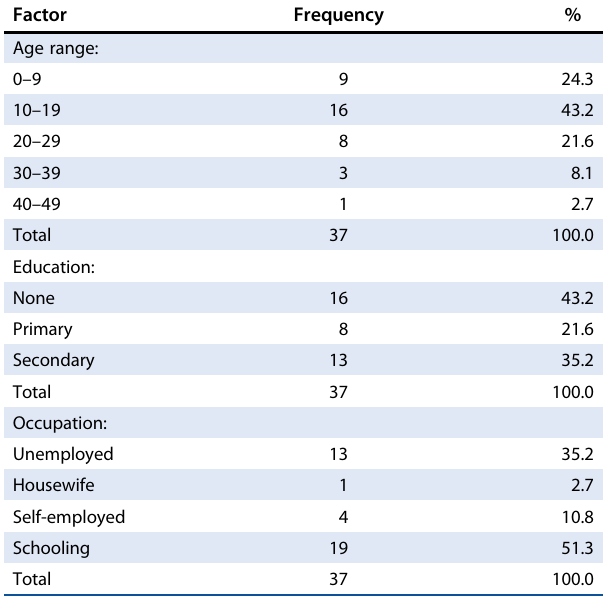
Table 1: Sociodemographic characteristic of subjects with typhoid ileal perforation